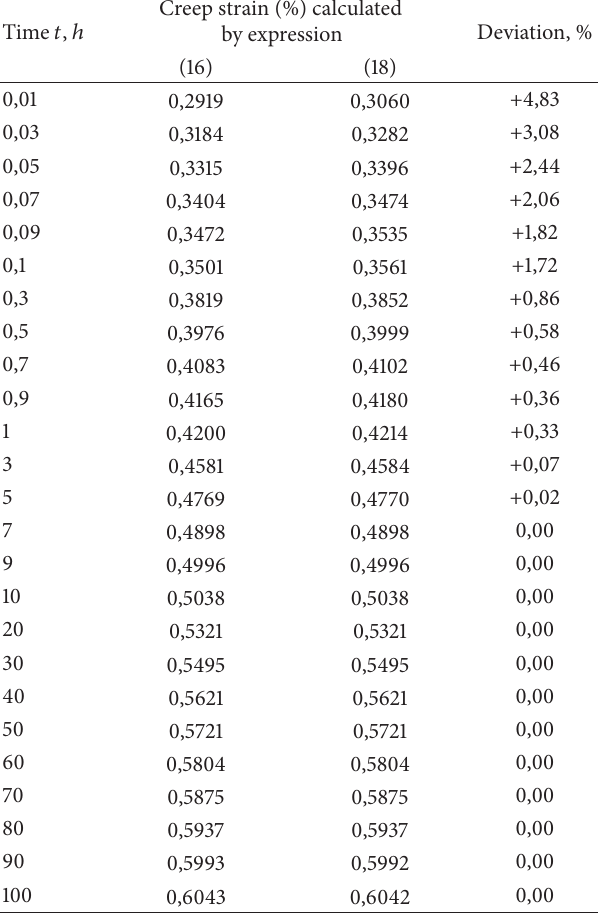
Table 2: Strains in sites I a and I b of material Nylon 6 creep curve.